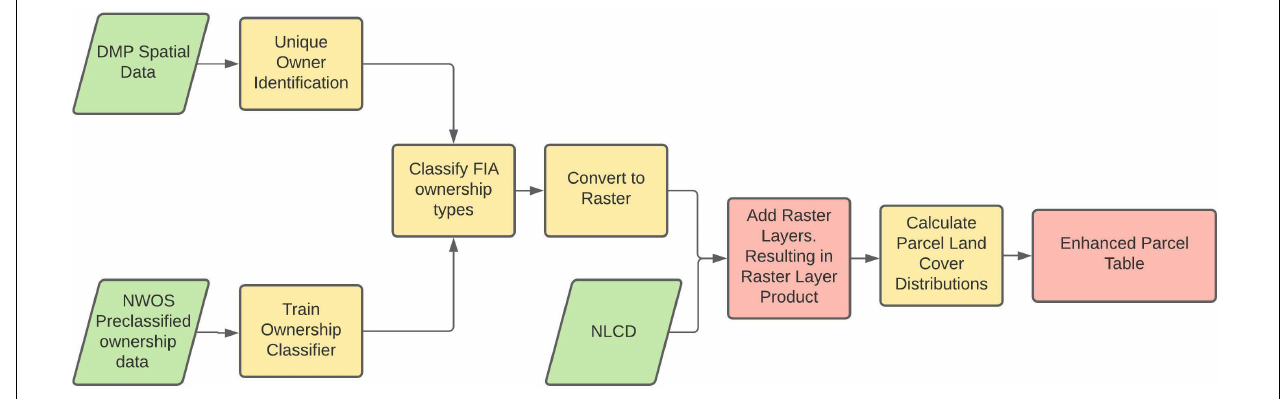
FIGURE 1 | Logic flow chart illustrating the process of creating a land cover and ownership spatial layer, from NLCD and a parcel ownership polygon